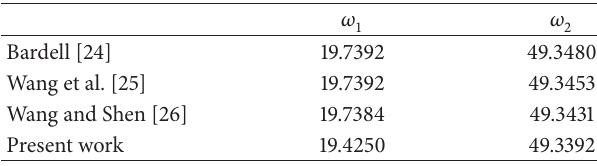
Table 1: Comparison of the results.